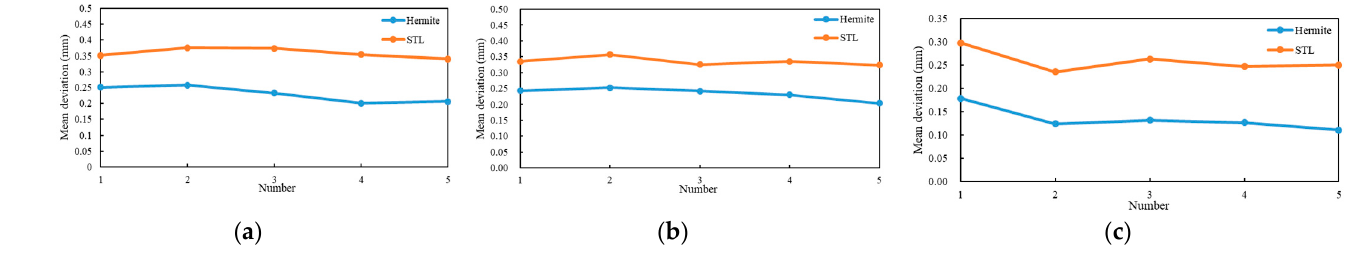
Figure 15. Variation in mean deviation: ( a ) Z-direction; ( b ) X-direction; ( c ) Y-direction. Table 5. Fi tt ing error results after removing the “noise” from the turbine model.